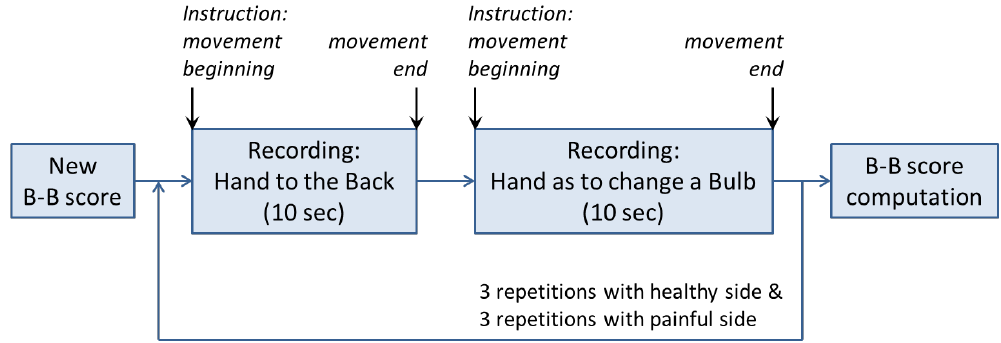
Figure 2. Schema of the application steps for the recording of a B-B